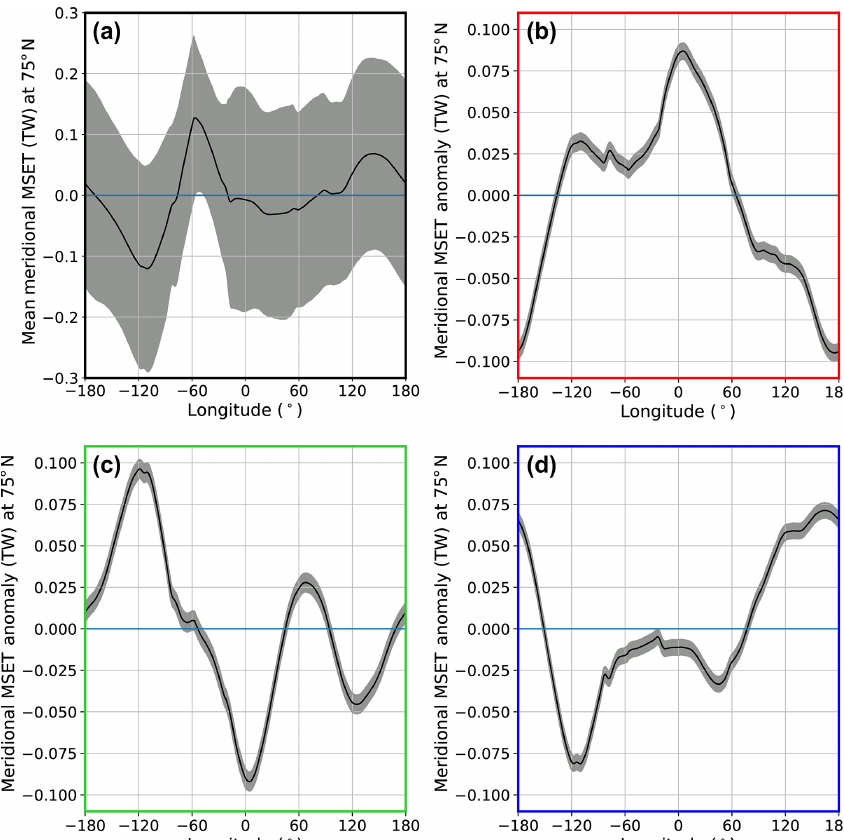
Figure 5. (a) Mean vertically integrated (surface to 200hPa) meridional MSE transport (MSET) at 75 ◦ N in terawatts (TW), grey shading shows the daily standard deviation. Composite of meridional MSE transport anomalies at 75 ◦ N given in TW for each of the three pathways: (b) North Atlantic pathway, (c) Siberian pathway, and (d) North Pacific pathway. Positive signs denote a transport anomaly to the north, negative signs denote a transport anomaly to the south, and grey shading shows the standard